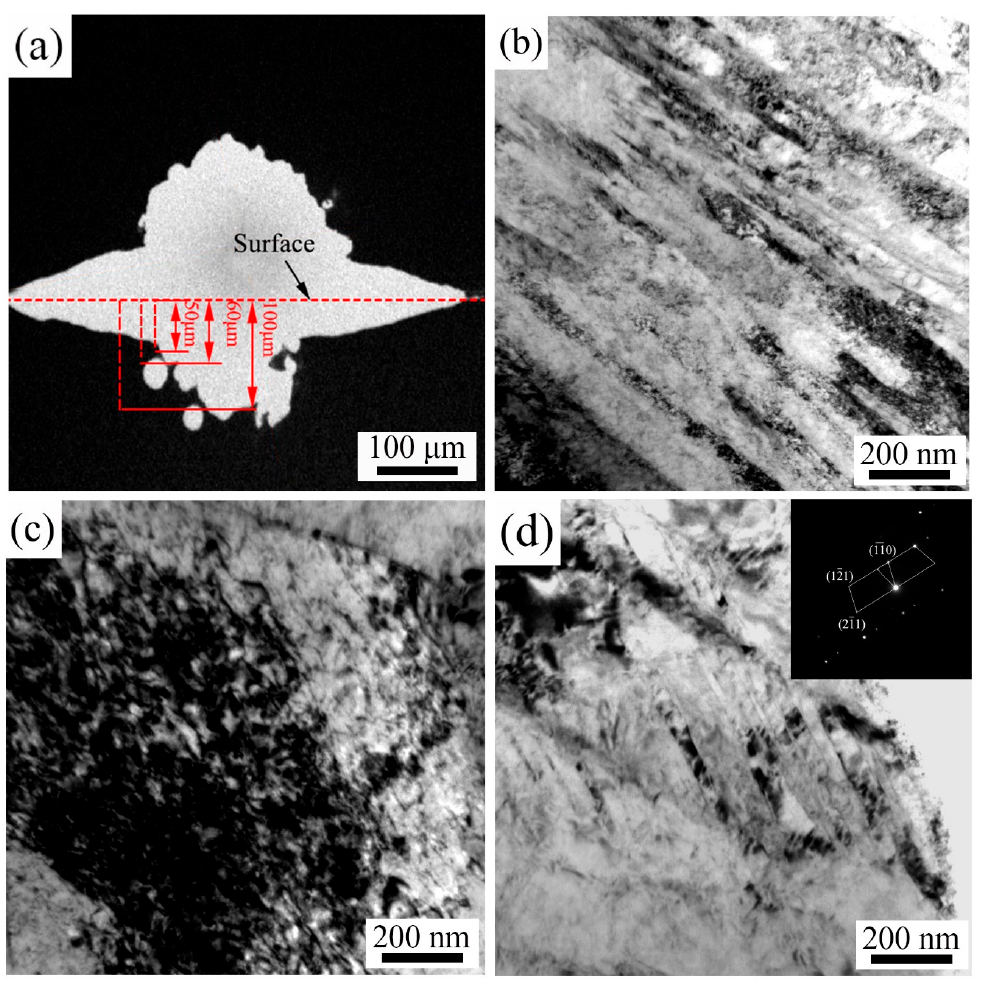
Figure 6. TEM (transmission electron microscopy) images of di ff erent areas. ( a ) The low-magnification TEM micrograph of the cross-section specimen. It is used to label the distance from the surface. The distance between ( b ) and the surface is 50 µ m, between ( c ) and the surface is 60 µ m, and between ( d ) and the surface is 100 µ m.